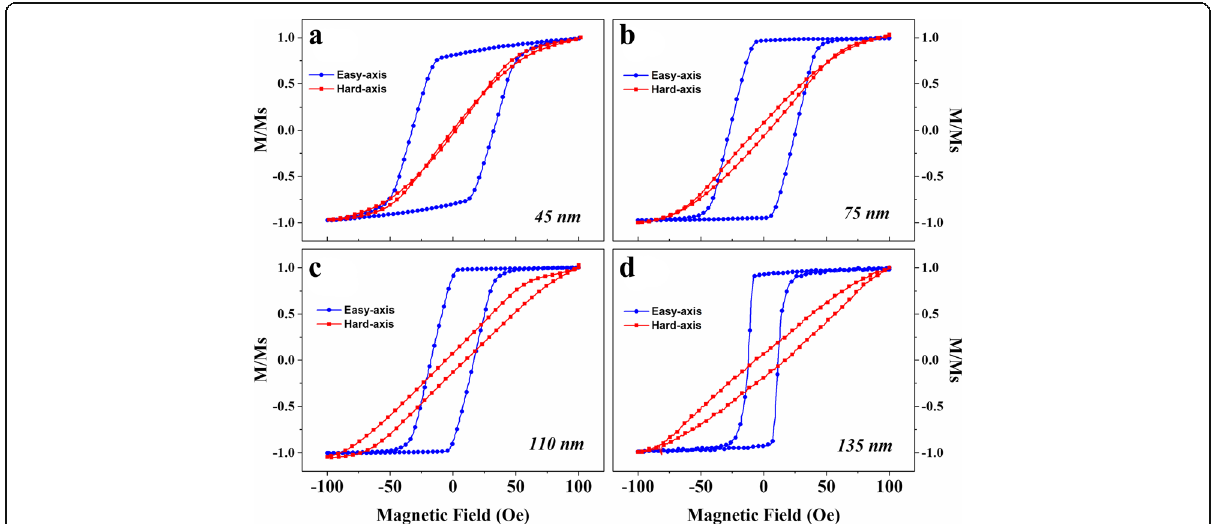
Fig. 2 The hysteresis loops of combined stripe patterned magnetic films with different thickness. The results are exhibited from easy-hard axis defined by induced magnetic field direction in each picture. From a to d , the thickness of films varied from 45 to 135 nm